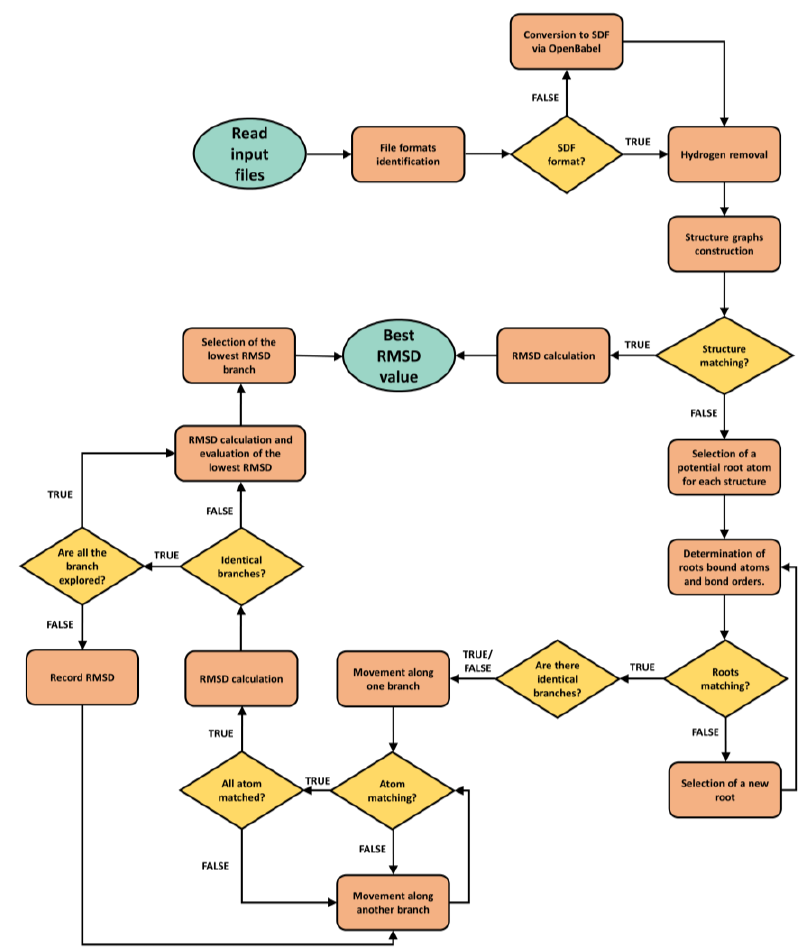
Figure 1. Flowchart of the ProRMSD algorithm. Output . PacVIEW output consists of interactive 3D structures of loaded files. Each loaded structure can be displayed in multiple style modes (licorice, ball and stick, cartoon, surface, etc.), with colours selected by the user. In addition, the user can not only rotate and translate the structures, but also choose different parameters regarding the visualisation and save images at different resolutions. For more details, users could refer to the related documentation on the PacDOCK web